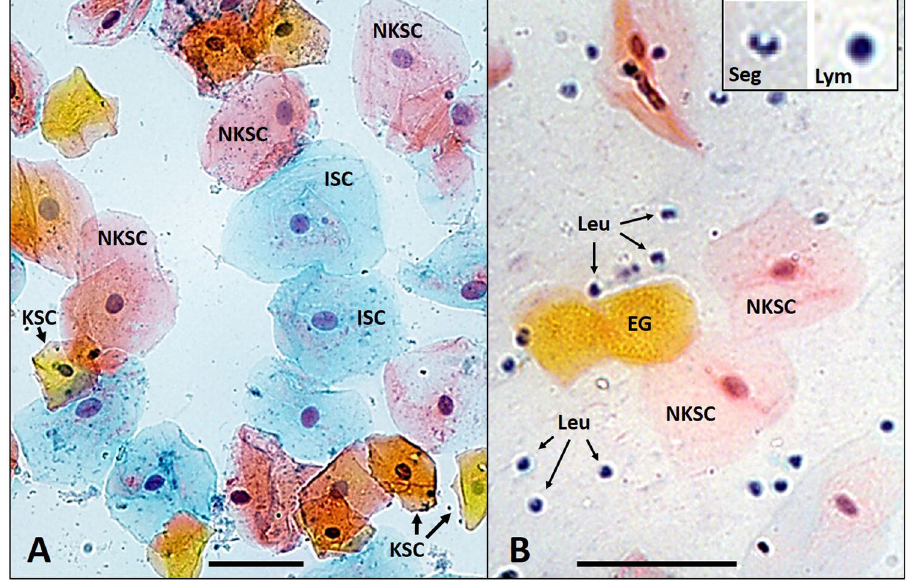
Figure 1. Examples of cellular morphology. Representative fields of view (200x magnification) of Pap staining of ( A ) a child’s buccal swab and ( B ) an adult’s saliva sample. The child’s buccal swab contains blue intermediate squamous cells (ISC), pink non-keratinized superficial squamous cells (NKSC) and orange keratinized squamous cells (KSC). The adult’s saliva sample also shows examples of enucleated orange ghost cells (EG), which were not included in our analysis, and a large number of leukocytes(Leu) with the insert showing a segmented cell (Seg) and a lymphocyte (Lym). The scale bars are 50 μ